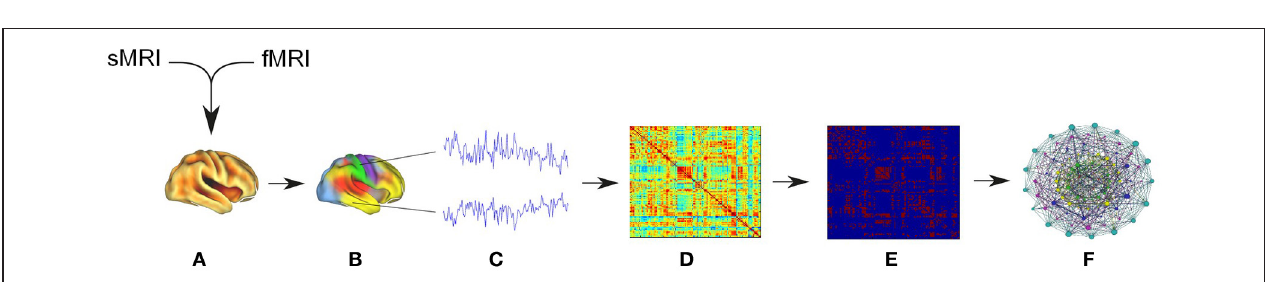
FIGURE 1 | Schematic diagram of different graph measures. In the upper row, starting from left, shows the degree , which is the number of edges connected to each node. As indicated here the red node has a degree of three. The clustering coefficient of a node is given as a ratio of its neighbors that are also linked to one another. The red node is connected to all three possible neighboring nodes but forming only 2 of the 3 possible closed triangles. Hence the clustering coefficient for this node is 2/3. The path length of the red node is four as minimum number of connections between